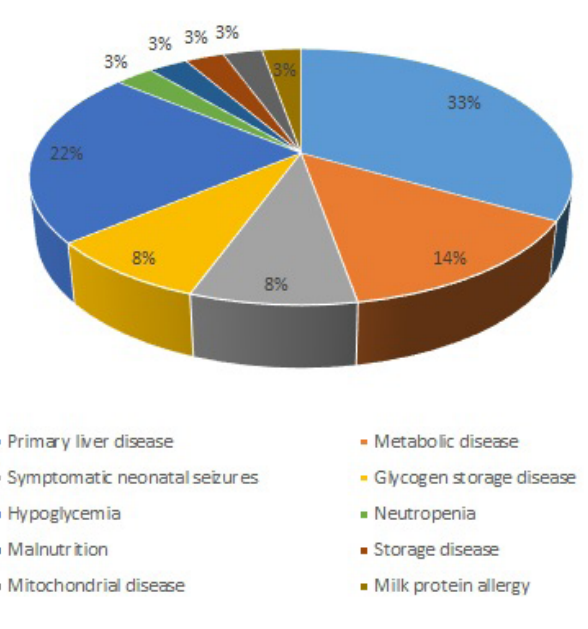
Figure 1. Referral